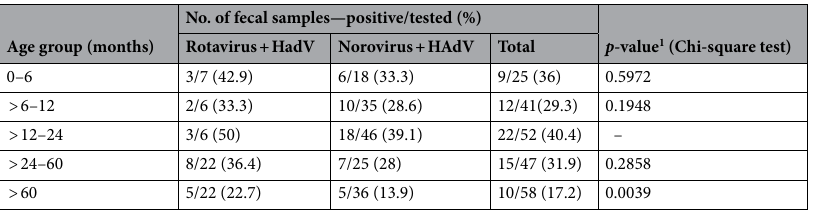
Table 4. Number of rotavirus and norovirus-positive samples tested to assess HAdV-positive frequency among co-detected samples through laboratory-based surveillance by age group in Brazil during 2018–2020. 1 p -values were calculated between the age group of > 12–24 months and each other.